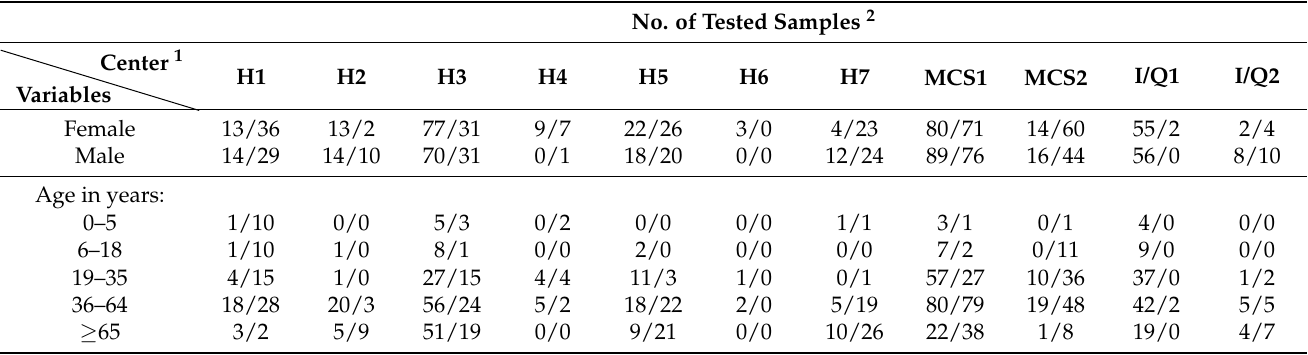
Table 2. Characteristics of the patients with samples subjected to SARS-CoV-2 variant differentiation by center, gender and age group.